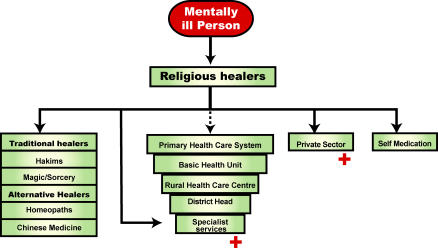
The Usual Model of Seeking Help for Mental Health Illnesses in Pakistan(Image: Aslam Bashir, Aga Khan University)